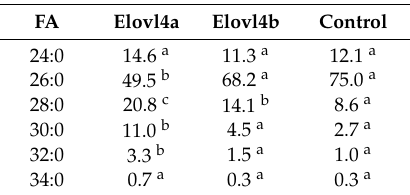
Table 1. Functional characterization of Sparus aurata Elovl4 elongases: role in the biosynthesis of very long-chain saturated fatty acids (FA).